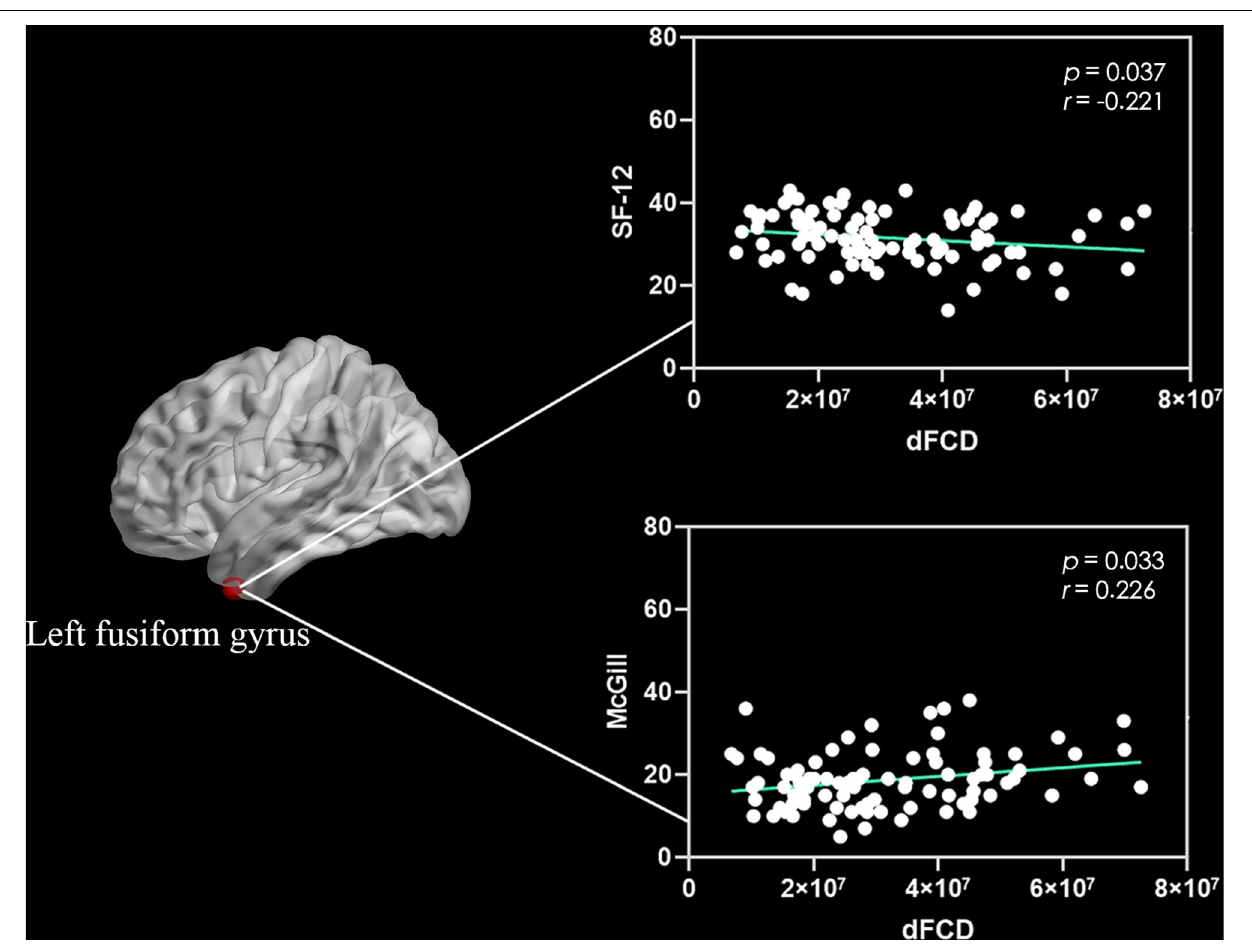
FIGURE 3 | Correlation between dynamic functional connectivity density (dFCD) variability in the left fusiform gyrus with McGill scores and SF-12 scores in the CNP group. SF-12, short form 12